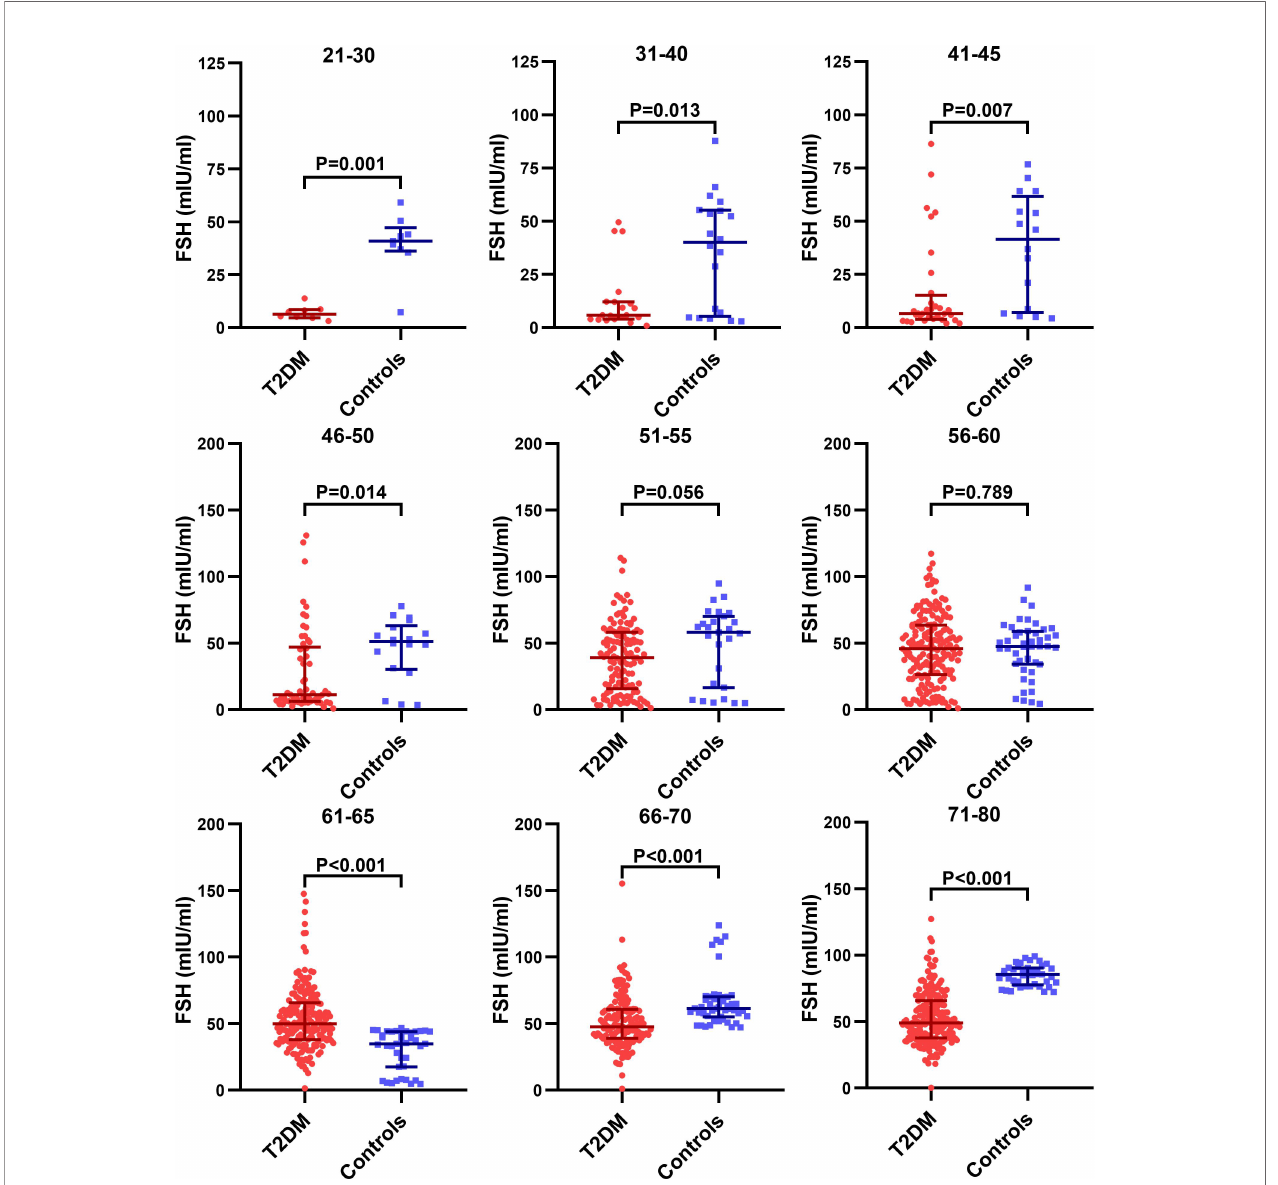
FIGURE 3 | Difference in the circulating FSH level between patients with T2DM and non-T2DM controls strati fi ed by